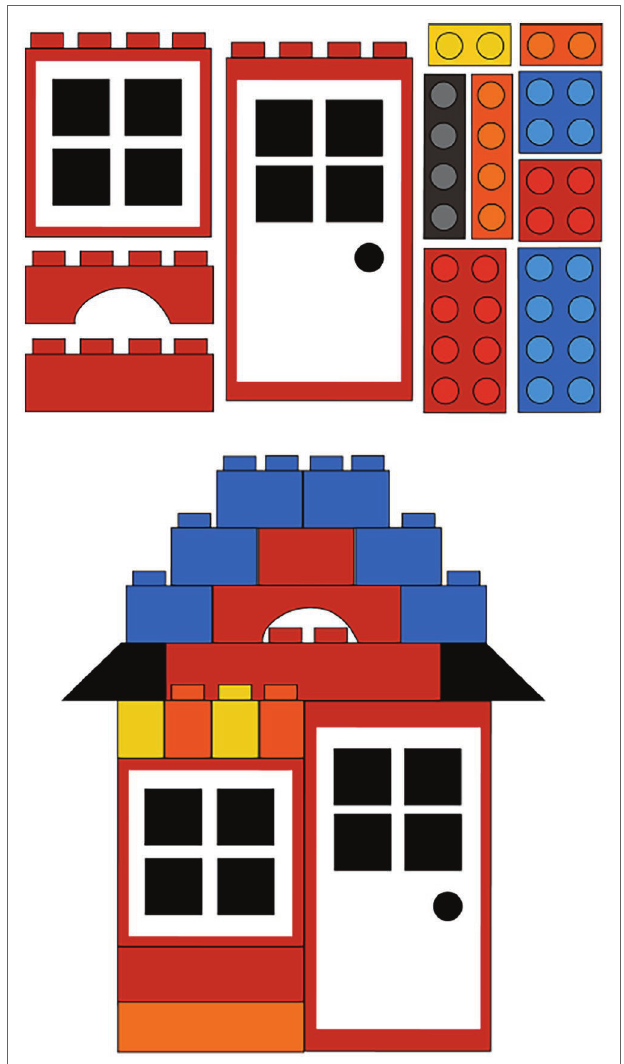
FIGURE 1 | Dyadic building task materials and completed structure.